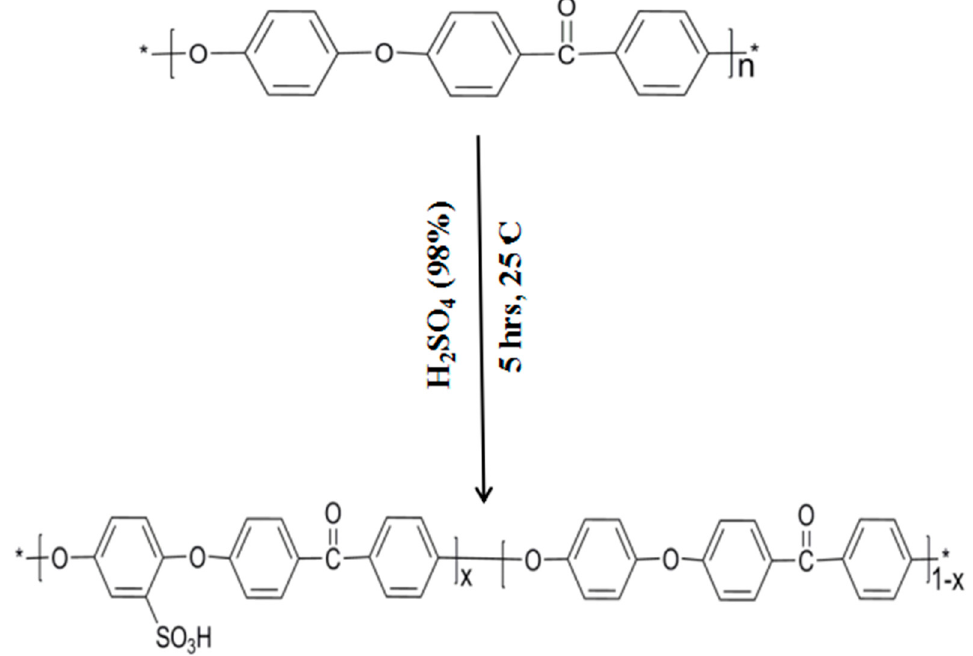
Figure 1. Sulfonation of PEEK.